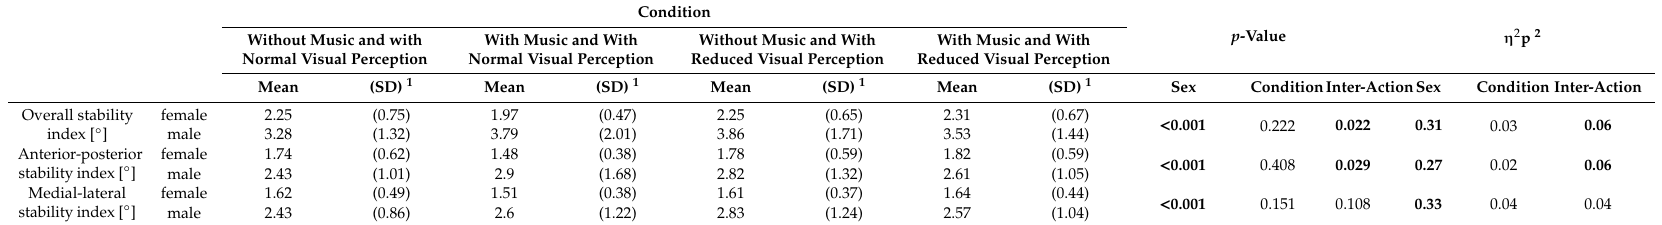
p -Value η 2 p 2 Without Music and with